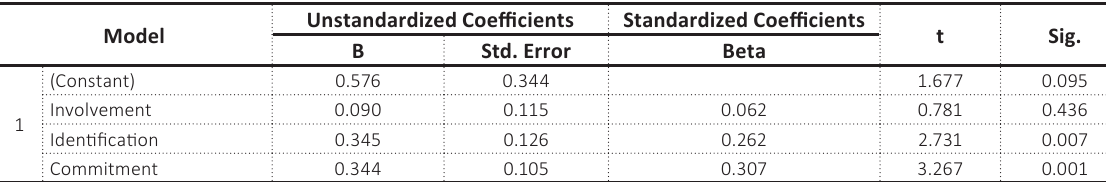
Table 6. Customer loyalty and customer intention coefficients